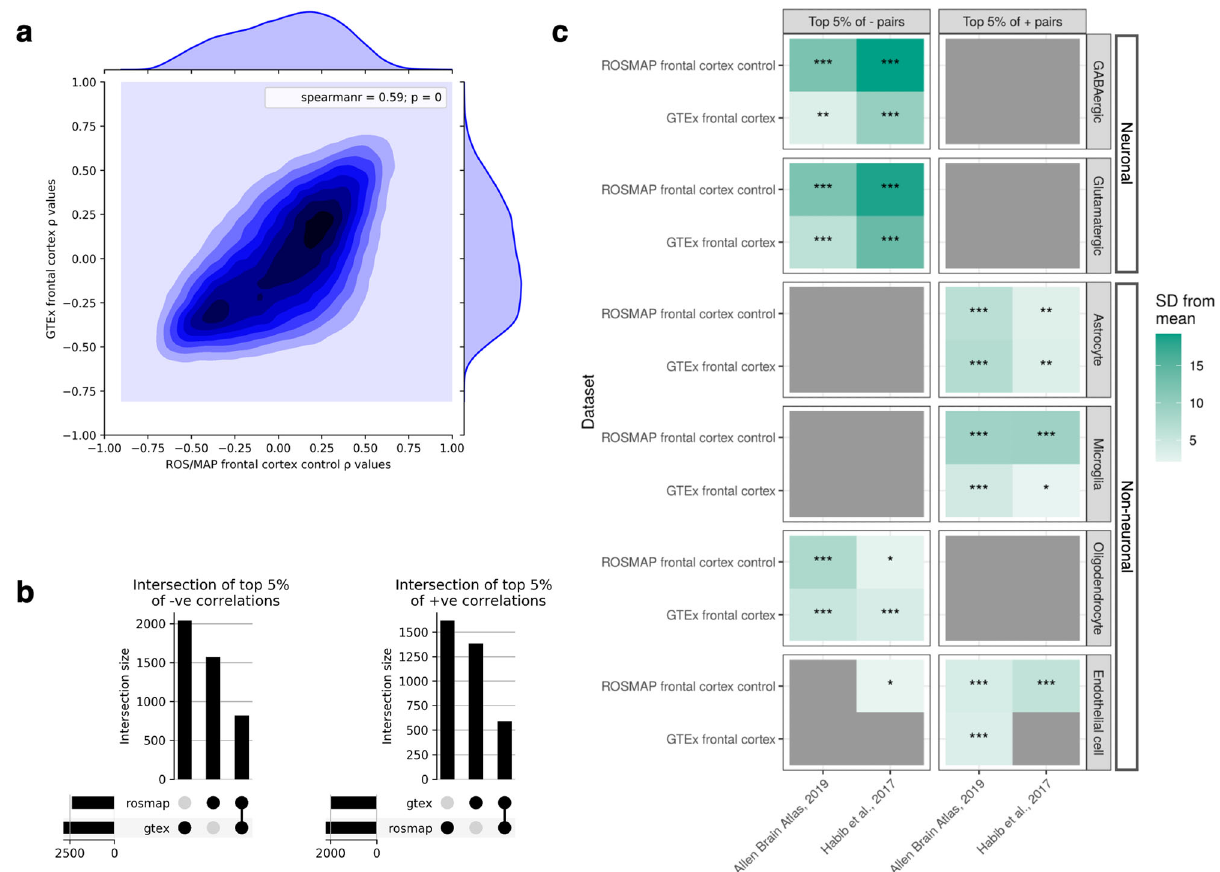
Fig. 4 Replication of the mitochondrial − nuclear correlation values and cell-type enrichments discovered in GTEx frontal cortex in an independent frontal cortex dataset (ROSMAP control samples). a Density-contour plot to show all mitochondrial − nuclear gene pairs commonly expressed in both datasets (177,320). ROSMAP ρ values are plotted on the x axis, and GTEx ρ values are plotted on the y axis. The Spearman correlation for the overall bi- dataset correlation and corresponding P value for the r statistic is given in the top right of the plot (Spearman ’ s ρ = 0.59, P < 2e − 16). b Upset plots to show numbers of unique nuclear genes found in the top 5% positive (left-hand plot) and top 5% negative correlations in the two datasets, and the overlap size of these gene sets. 817 nuclear genes were found in the top 5% of negative pairs for both datasets, and 588 nuclear genes were found in the top 5% of positive pairs for both datasets. Thus, 52% and 36% of unique nuclear genes from negative and positive mitochondrial − nuclear pairs discovered in GTEx replicate in the ROSMAP control dataset. c EWCE-derived cell-type enrichments for GTEx frontal cortex and ROSMAP frontal cortex. The y axis denotes the RNA-seq source. For each association, the following asterisks are overlaid to indicate the multiple test correction threshold passed: *0.05/ 12 < P < 0.05; **0.05/12*6 < P < 0.05/12; *** P < brain data were robust, we considered mitochondrial − nuclear gene expression correlations in neurological control samples from the ROSMAP dataset. Since ROSMAP data are derived from dorsolateral prefrontal cortex tissue, we compared the fi ndings to those generated from the GTEx frontal cortex tissue only.